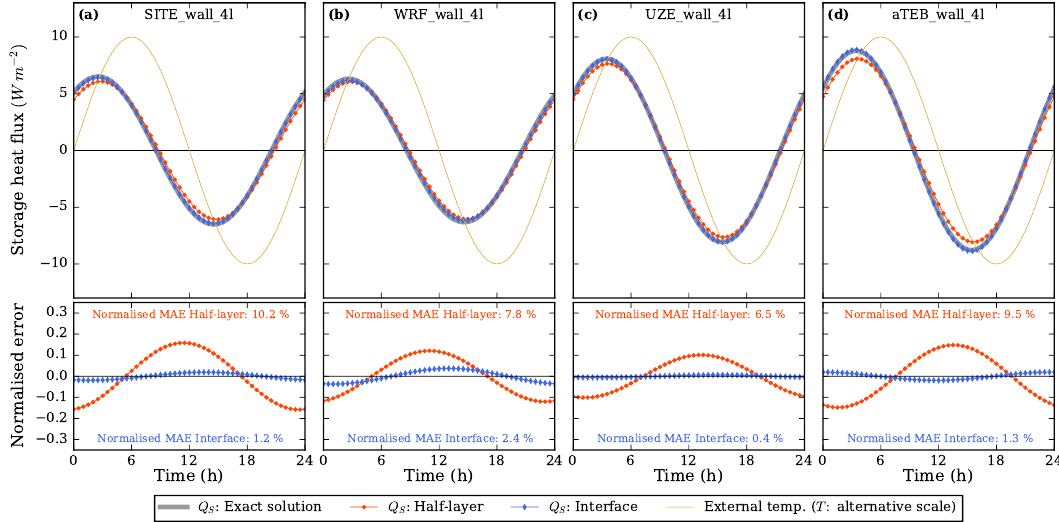
Figure 4. Heat storage response of half-layer and proposed interface schemes vs exact solutions for four wall types: (a) SITE: a composite of realistic materials at the Melbourne observation site (Grimmond et al., 2011); (b) WRF: a homogeneous material which forms the default parameters for WRF land surface schemes (Chen et al., 2011); (c) UZE: a homogeneous material optimised to reduce WRF errors at 15 urban locations (Loridan and Grimmond, 2012); (d) an optimised composite used in aTEB (Thatcher and Hurley, 2012), based on the ECOCLIMAP database (Masson et al., 2003). For more information on material parameters, refer to Appendix A. Upper panels show storage heat flux density over a periodic cycle, lower panels show normalised error from exact solutions. The interface scheme reduces errors for these wall